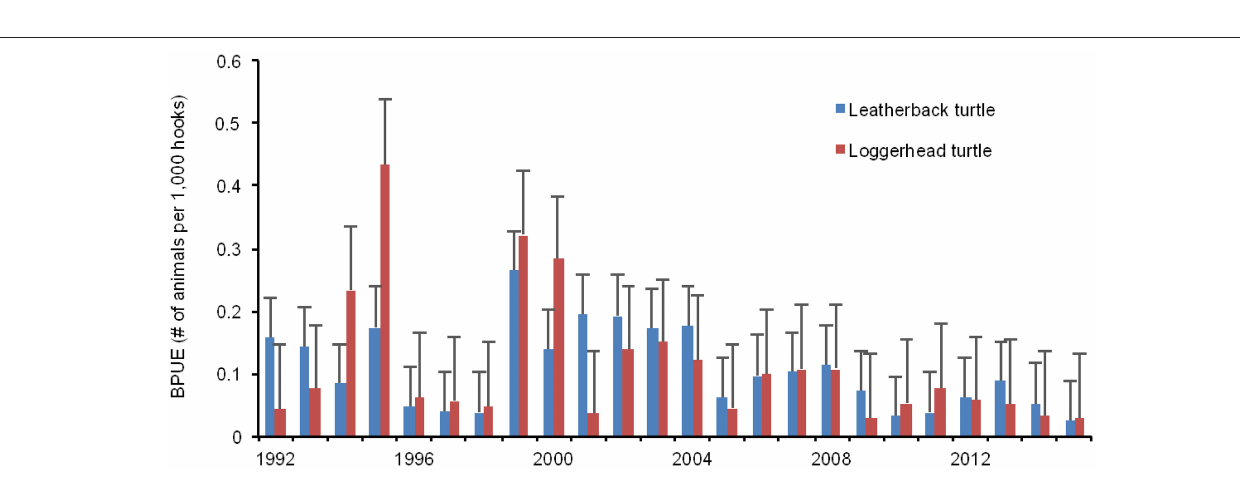
captures occurred between 17 and 19 ◦ C for both loggerheads and leatherbacks ( Figure 5